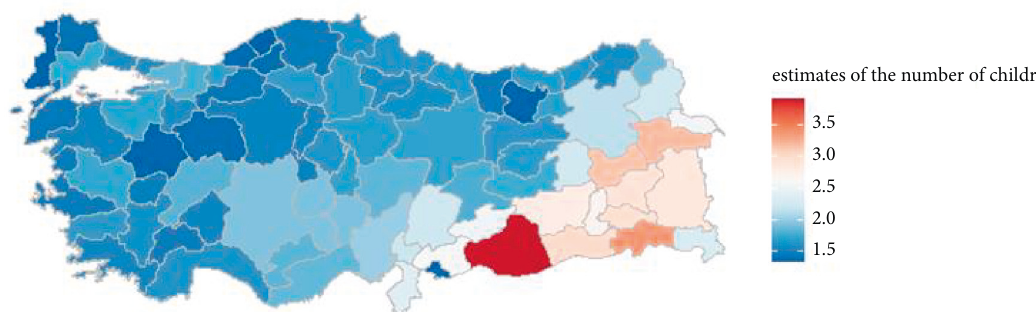
Figure 2: Spatial distribution of total fertility rate estimates in Turkey for